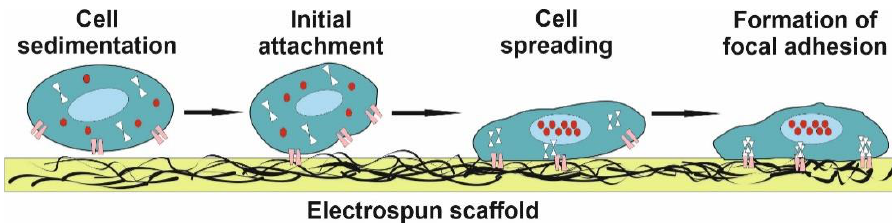
Figure 1. The successive stages of cell – scaffold interaction.